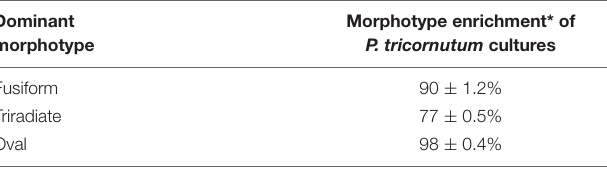
Morphotype enrichment* of P. tricornutum cultures